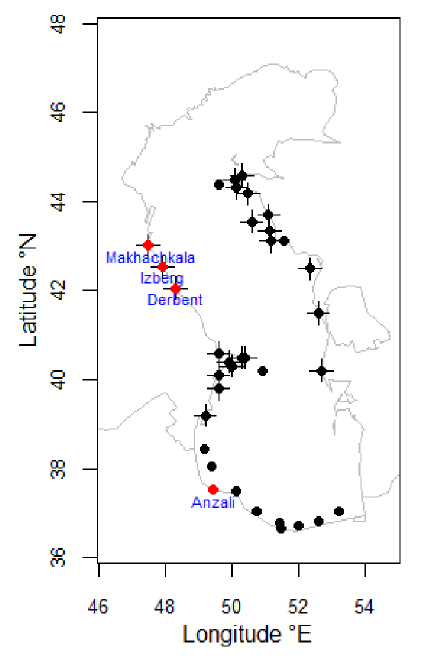
Fig. 4. Wave observation or measurement sites in the Caspian Sea (Table 1). The sites used for validation of JASON-1 wave heights are marked with red points and names in blue. Crosses indicate the measurement sites that perform only visual observation of wave heights.